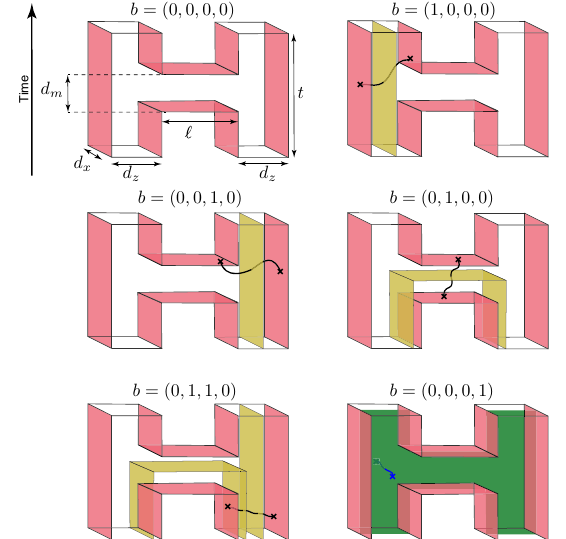
FIG. 8. A space-time diagram of a lattice-surgery protocol, illustrating different types of failure mechanisms represented by the vector b = ( b ZL , b TL , b ZR , b X ) . For each element b j in the vector b , we associate a logical sheet (shown in yellow or green when triggered) and we have b j = 1 if and only if the relevant error type crosses the logical sheet an odd number of times. The Z strings trigger yellow logical sheets and termi- nate on pink boundaries. The X strings trigger green logical sheets and terminate on the foreground and background bound- aries (these are transparent for visual clarity). For instance, a ( 1, 0, 0, 0 ) event (top right) occurs in the presence of a logical Z stringlike excitation on the left surface-code patch. Since the excitation does not cross the yellow (cid:13) -shaped logical sheet, the correct outcome of the multiqubit Pauli measurement is recorded. A ( 0, 1, 0, 0 ) event (middle right) is a pure timelike failure, where the incorrect multiqubit Pauli-measurement outcome is recorded without introducing additional logical Z failures to the two log- ical patches. This holds because the Z string only crosses the yellow (cid:13) -shaped logical sheet. A ( 0, 1, 1, 0 ) event (bottom left) occurs when a Z stringlike excitation crosses the rightmost yel- low logical sheet in addition to the yellow (cid:13) -shaped logical sheet. Such an error results in both a logical Z error on the right logi- cal patch in addition to a timelike lattice-surgery failure. Lastly, we illustrate an X stringlike excitation crossing the green logical sheet, resulting in a logical X failure on both logical patches.